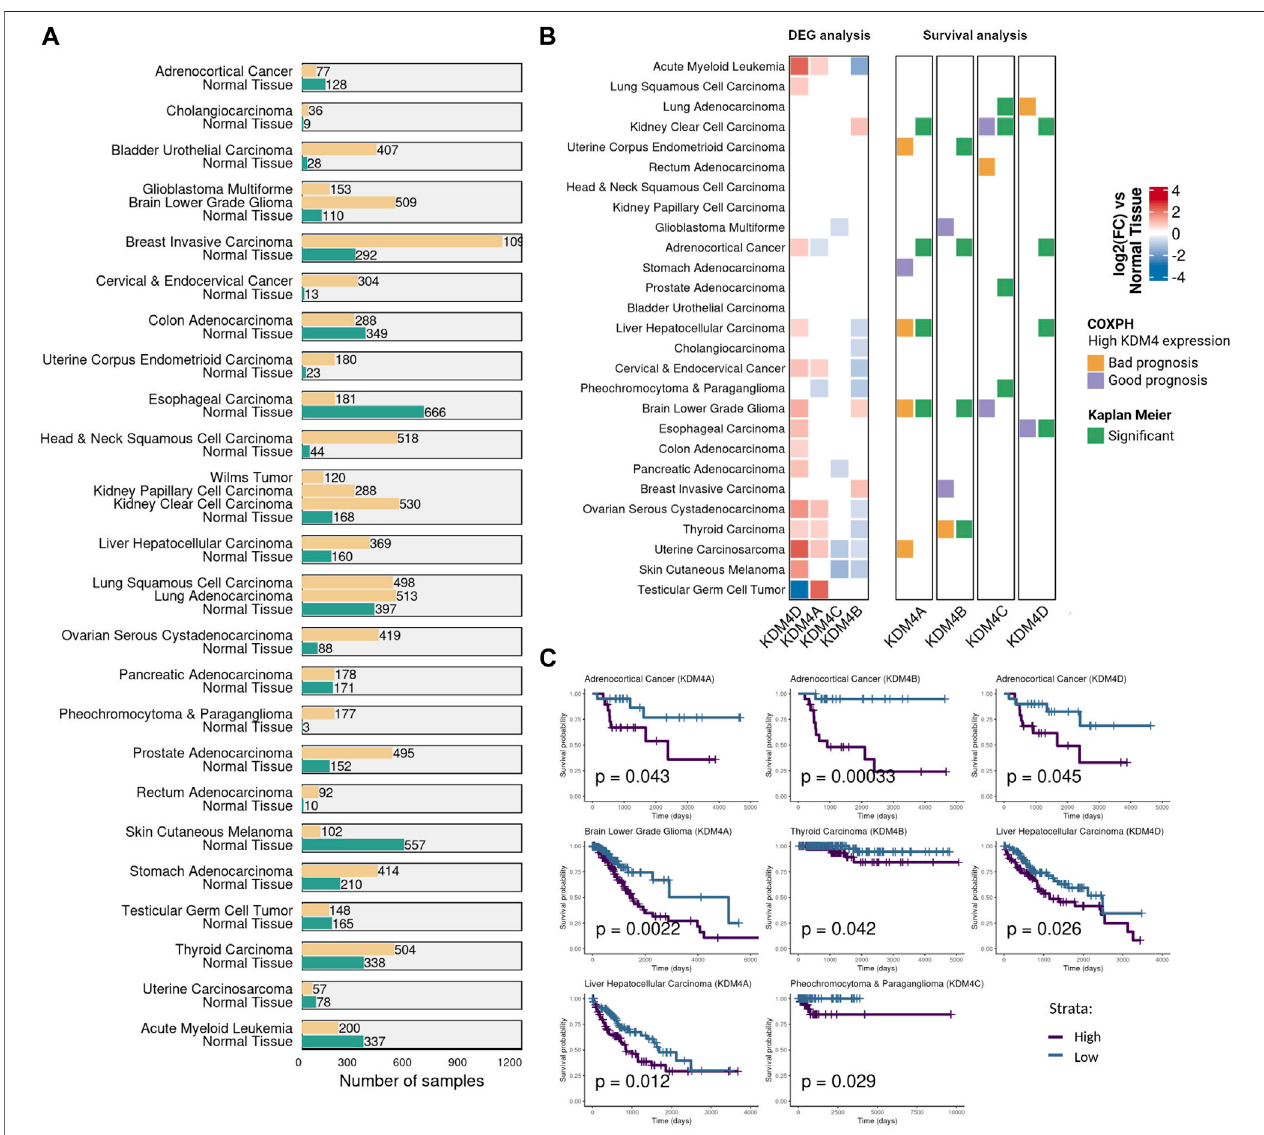
FIGURE 1 | KDM4 family expression in cancer. (A) The number of samples used for the transcriptomic and survival analysis. Samples were obtained from TCGA, TARGET and GTEx databases. (B) Gene expression and survival analysis for each KDM4 protein. The fi rst panel shows the differential expression analysis of the tumor samples vs. the non-neoplastic tissue. The second panel shows the CoxPH and Kaplan Meier survival analysis as adjacent columns for each KDM4 protein. For CoxPH analysis( fi rstcolumn),thetilecolorindicatesifhighlevelsoftheKDM4areofbadorgoodprognosis( p value < 0.05).FortheKaplan-Meieranalysis(secondcolumn), tumor samples were divided into two groups according to their KDM expression: Low-KDM and patients with High-KDM ( p value < 0.05). White tiles represent non signi fi cantassociation. (C) Signi fi cantKaplanMeiercurvesoftheKDM4proteinoverexpressedinthecancertypewhereonlyabadprognosisrelationshipwasfoundwith p value <